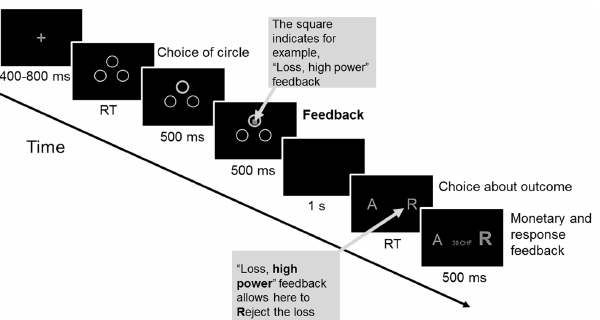
Fig 2. An example of a gambling task trial of Experiment 1. Presentation times of each trial event are indicated below the corresponding screen. At feedback onset, the information of goal conduciveness and power appraisals was simultaneously presented via a geometric shape in gray or black. At “ Choice about outcome ” participants decided about the outcome: A = accepting. R = rejecting. RT = reaction time.